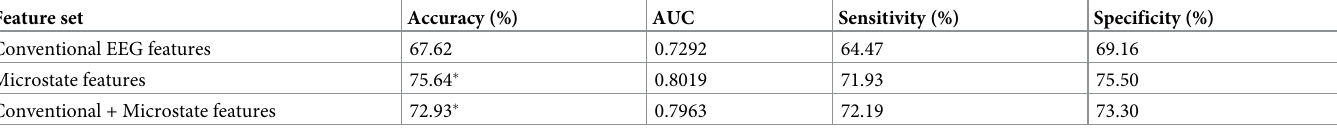
Table 3. Classification accuracies with quadratic SVM classifier using 19 microstate and 155 conventional EEG features obtained from the EEG dataset for patients diagnosed with schizophrenia and healthy (control) subjects. Feature set